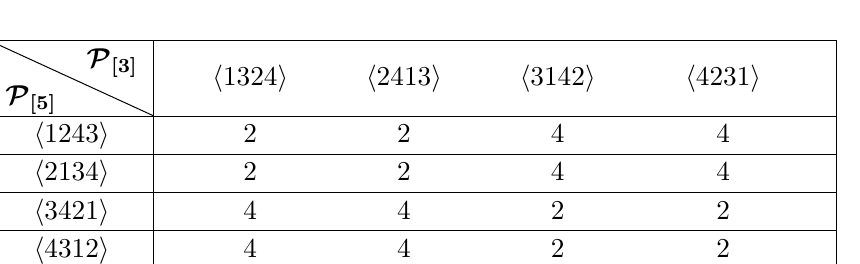
Table 14. {P} 5 − {P} 3 two-point correlator